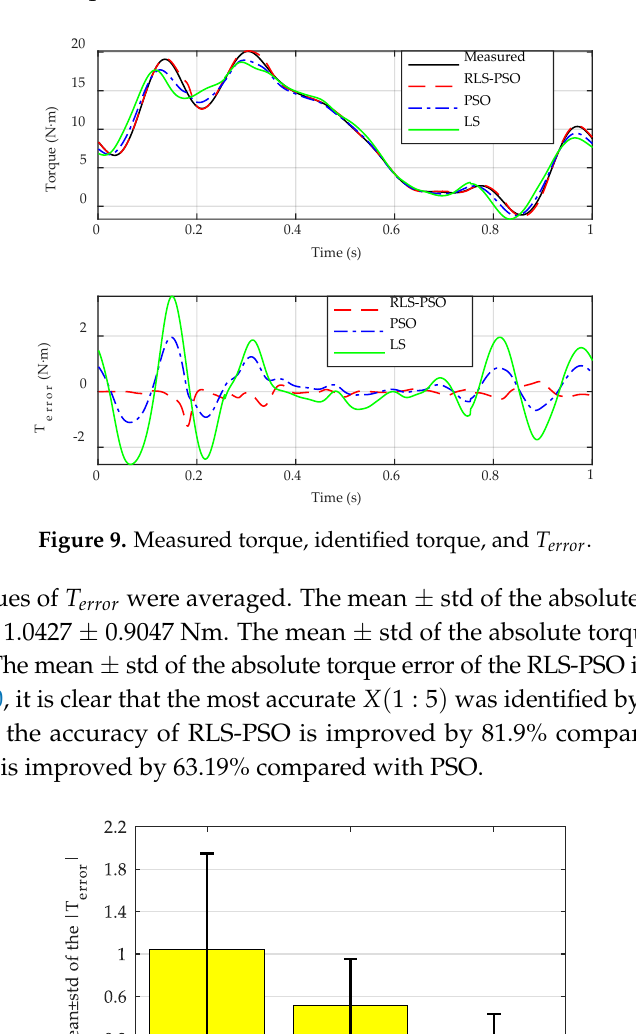
Figure 10. The mean ± std. of the absolute errors.